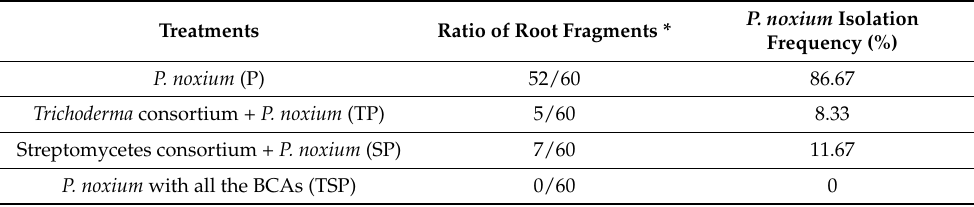
Table 3. Re-isolation frequency of P. noxium from the root samples of the Fig plants. Treatments Ratio of Root Fragments